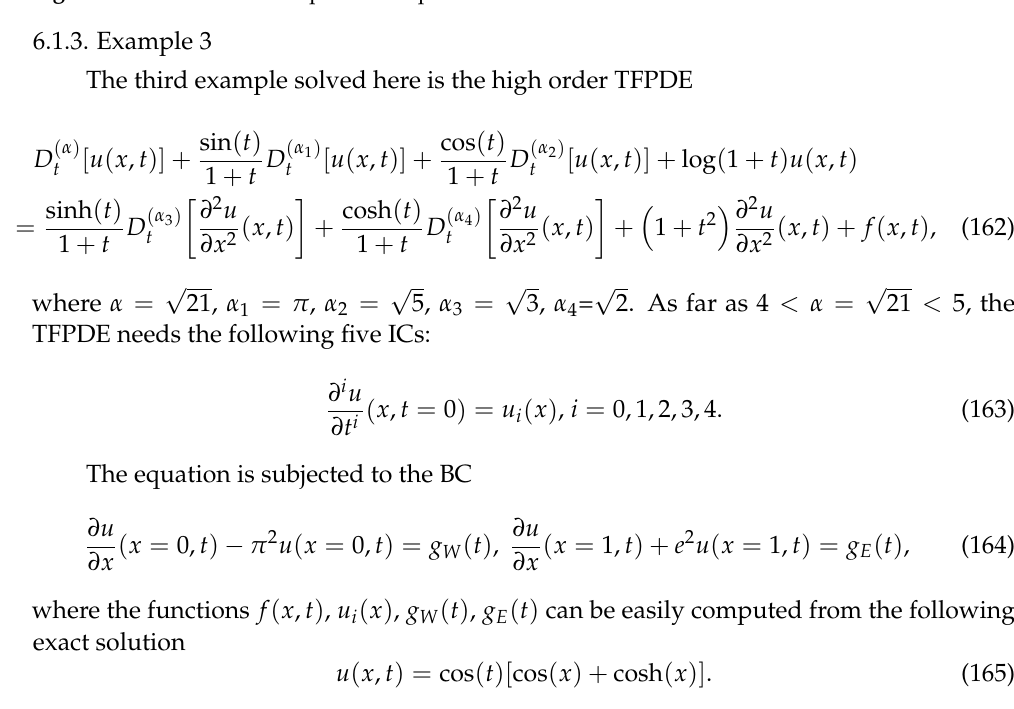
Figure 1. The MAE with respect to the parameters M and N